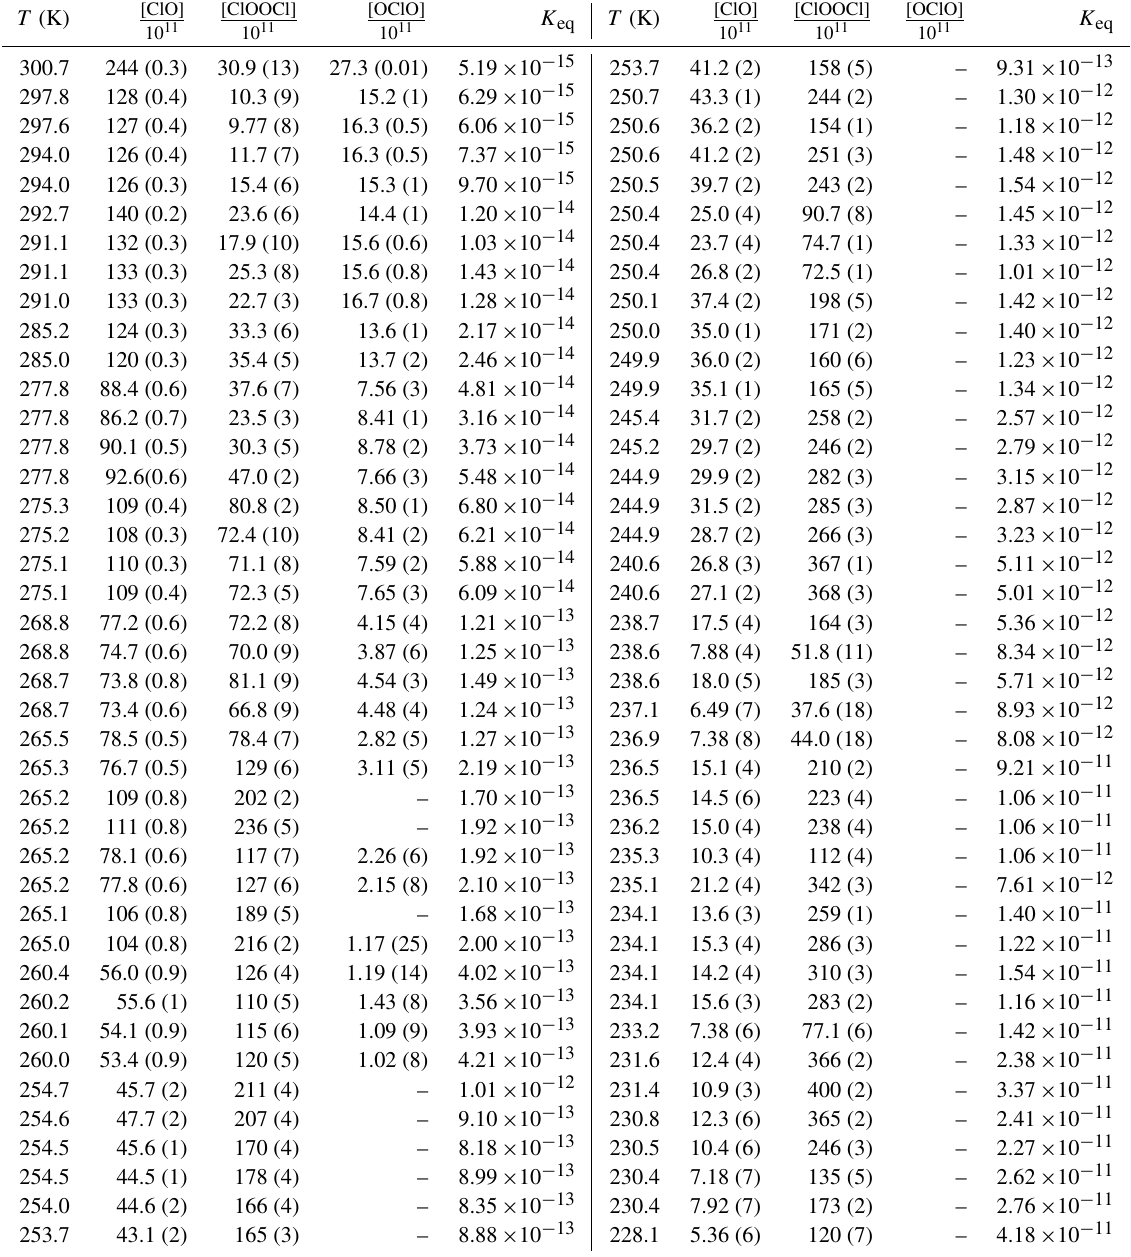
Table 1. Experimental conditions a , concentrations from spectral deconvolution b , and K eq values c . T